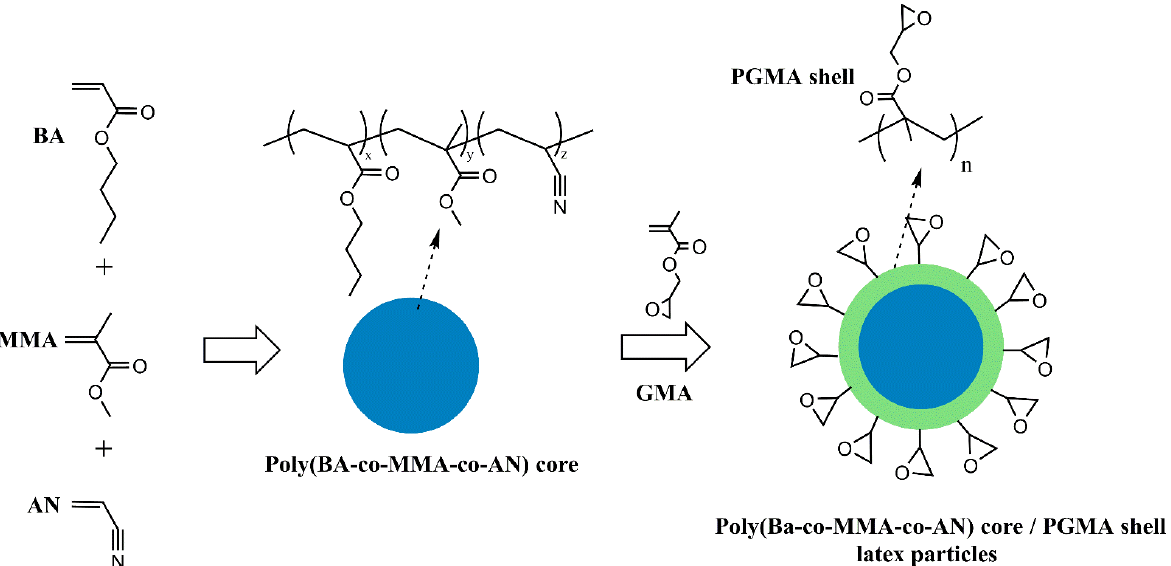
Table 1. The composition of acrylic